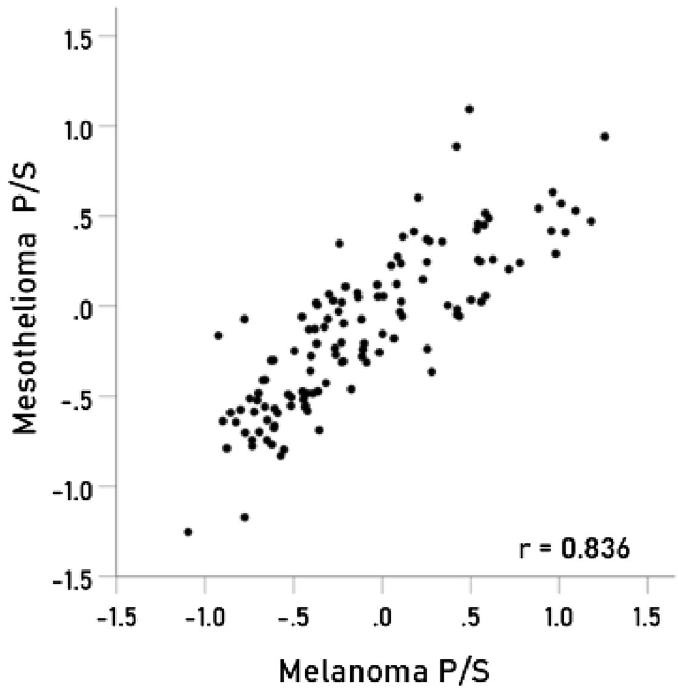
Figure 8. Immunogenetic P/S estimates for mesothelioma are plotted against those for melanoma. P < 0.001; N =